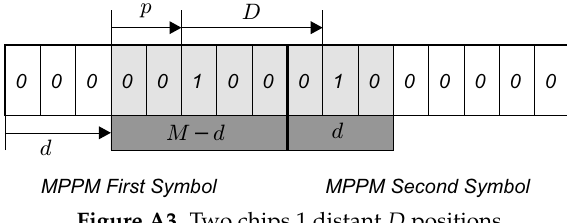
Figure A3. Two chips 1 distant D positions.